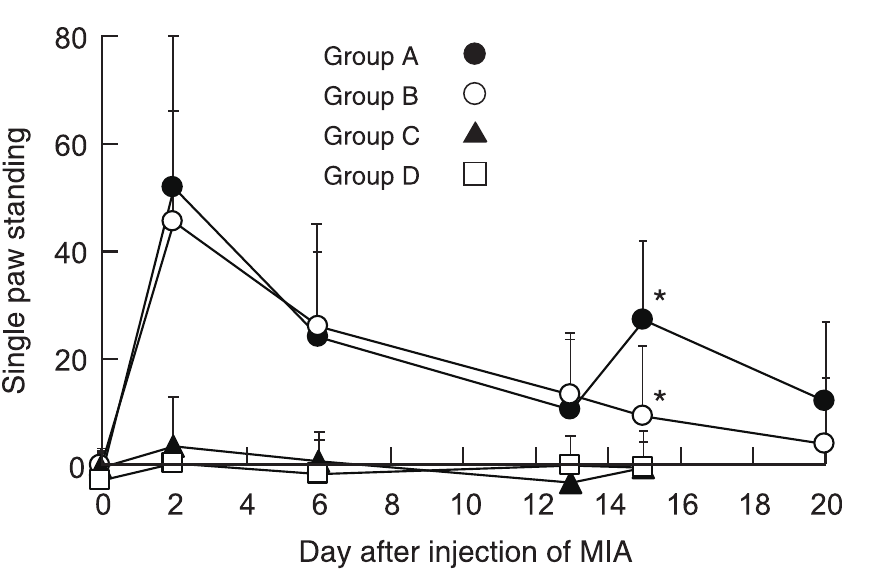
Fig 4. Observation of pain-related behavior of mice belonging to group A, B, C, and D. Single paw standing was calculated on day 0, 2, 6, 13, 15 and 20 according to the methods described under Materials and methods. Data from five experiments were combined. Total number of mice used were 24, 20, 8, and 15 for group A, B, C and D, respectively. SDs were indicated by bars. � p < 0.001.